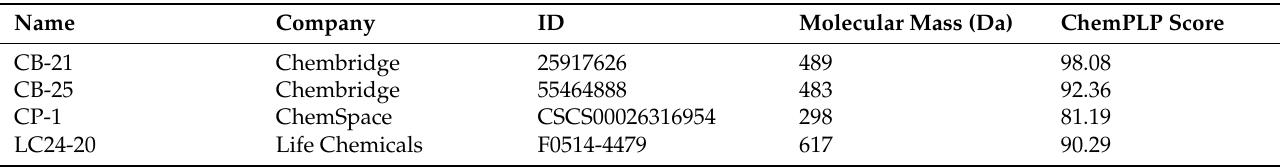
Table 1. Docking score of selected